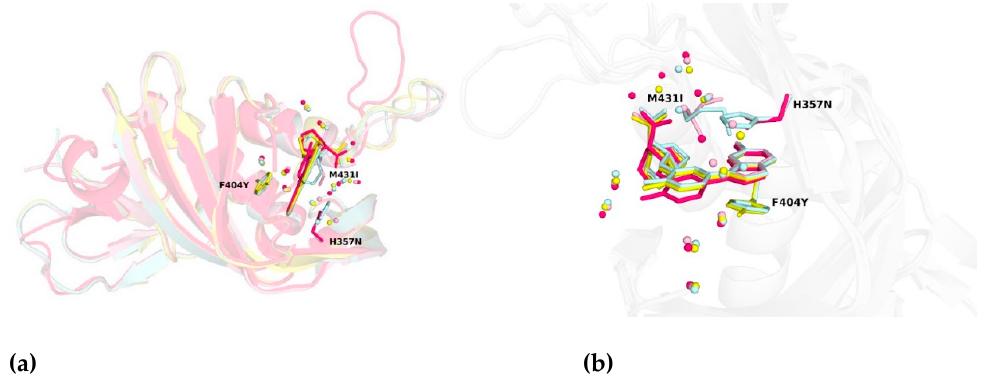
Figure 5. ( a ) Structural alignment of PB2 wild-type and three-point mutation variants in complex with pimodivir. ( b ) Close-up view on the alignment of PB2 crystal structures. Water molecules proximal to the cap-binding site are presented as spheres. The overall structure is depicted as cartoon model with important residues shown as sticks. Color coding is as follows: PB2-WT in pale cyan, PB2-F404Y in yellow, PB2-M431I in light pink, and PB2-H357N in pink.